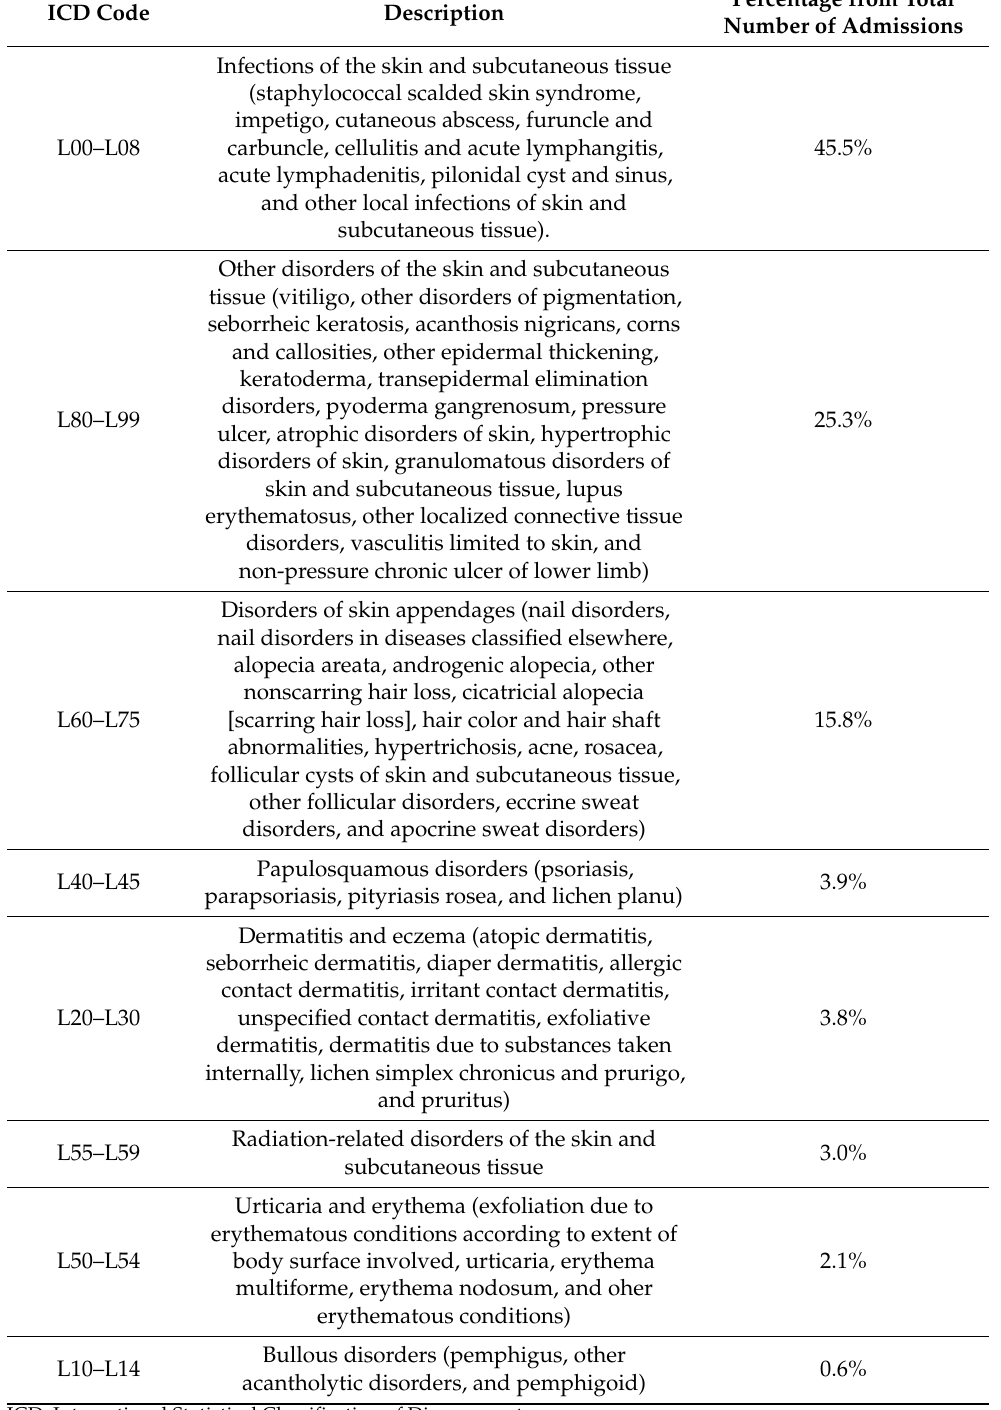
Table 1. Percentage of diseases of the skin and subcutaneous tissue hospital admission from the total number of